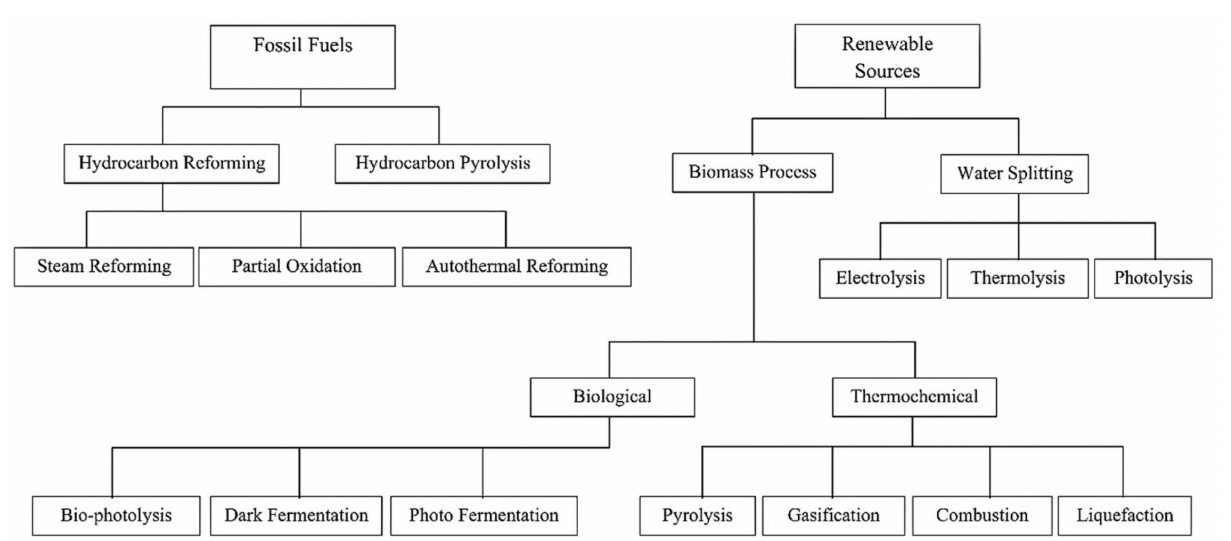
Figure 3. Routes to hydrogen production [28,40]. Reproduced with permission from Elsevier,